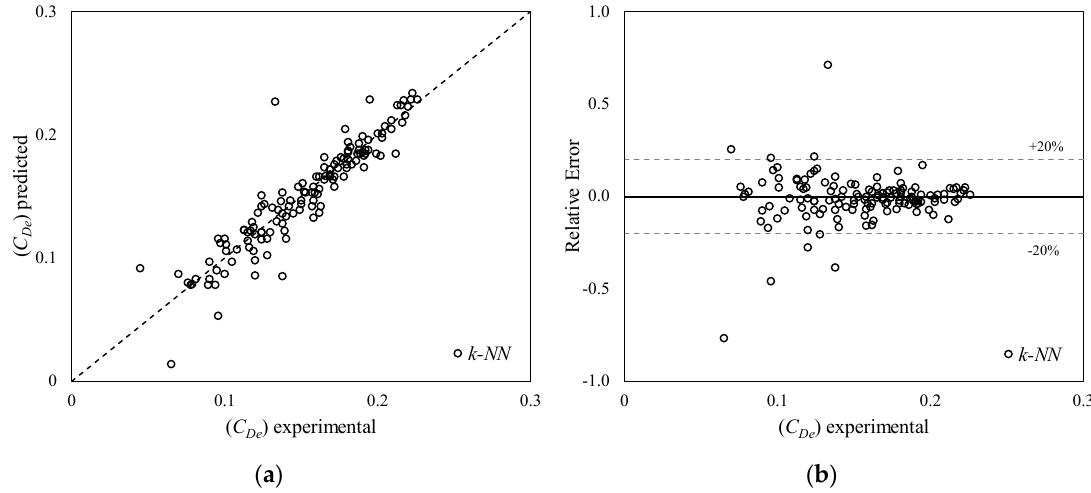
Figure 9. Model 2, k-NN algorithm, ( a ) predicted versus experimental results, and ( b ) relative error versus experimental results.